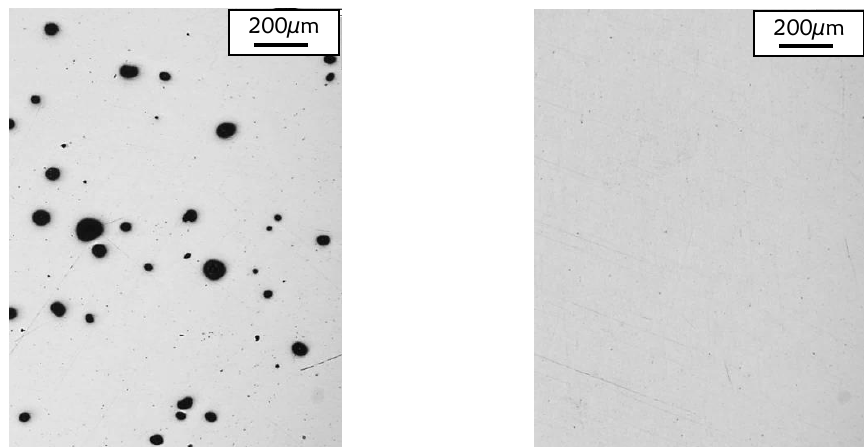
Figure 21: Porosity in SLM IN718 (left) and no visible porosity after HIP’ing (right).